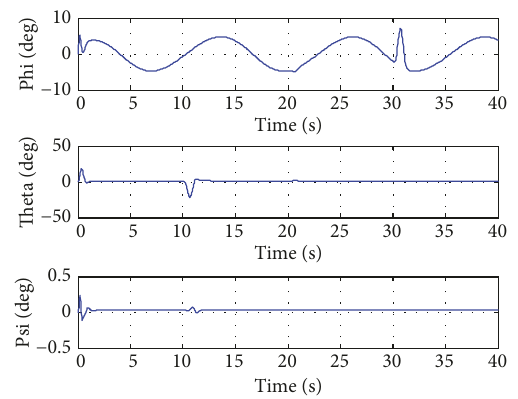
Figure 12: The curve of the attitude angle.